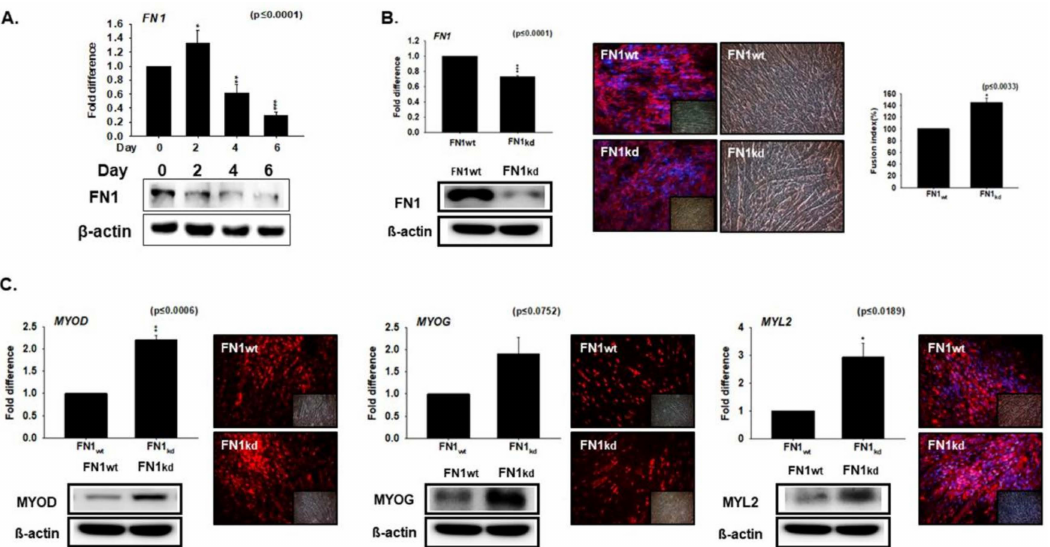
Figure 3. Fibronectin (FN) knockdown expression during myoblast di ff erentiation. ( A ) C2C12 cells were cultured with 2% FBS for 0, 2, 4, and 6 days. FN mRNA levels were assessed by real-time RT-PCR, and protein expression by Western blot. ( B ) FN knock-down was performed and cultured with 2% FBS for 4 days. mRNA expression were assessed by real-time RT-PCR, protein expression by Western blot and immunocytochemistry, And myotube formation and fusion index by Giemsa staining. ( C ) The mRNA expression assessed by real-time RT-PCR and protein expression by Western blot and immunocytochemistry in FN kd and FN wt cells are shown. FN wt indicates cells transfected with